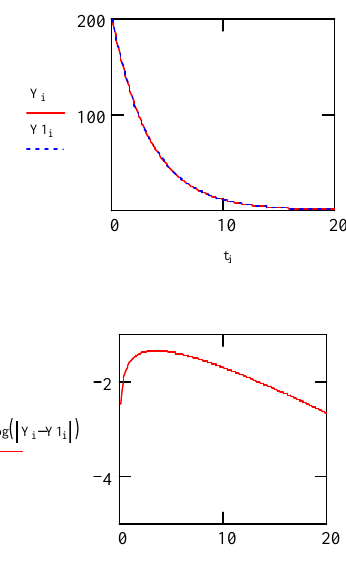
Fig. 2. Comparison of the estimated solutions, Y i , with the “experimental data” and the absolute error in the decimal logarithmic